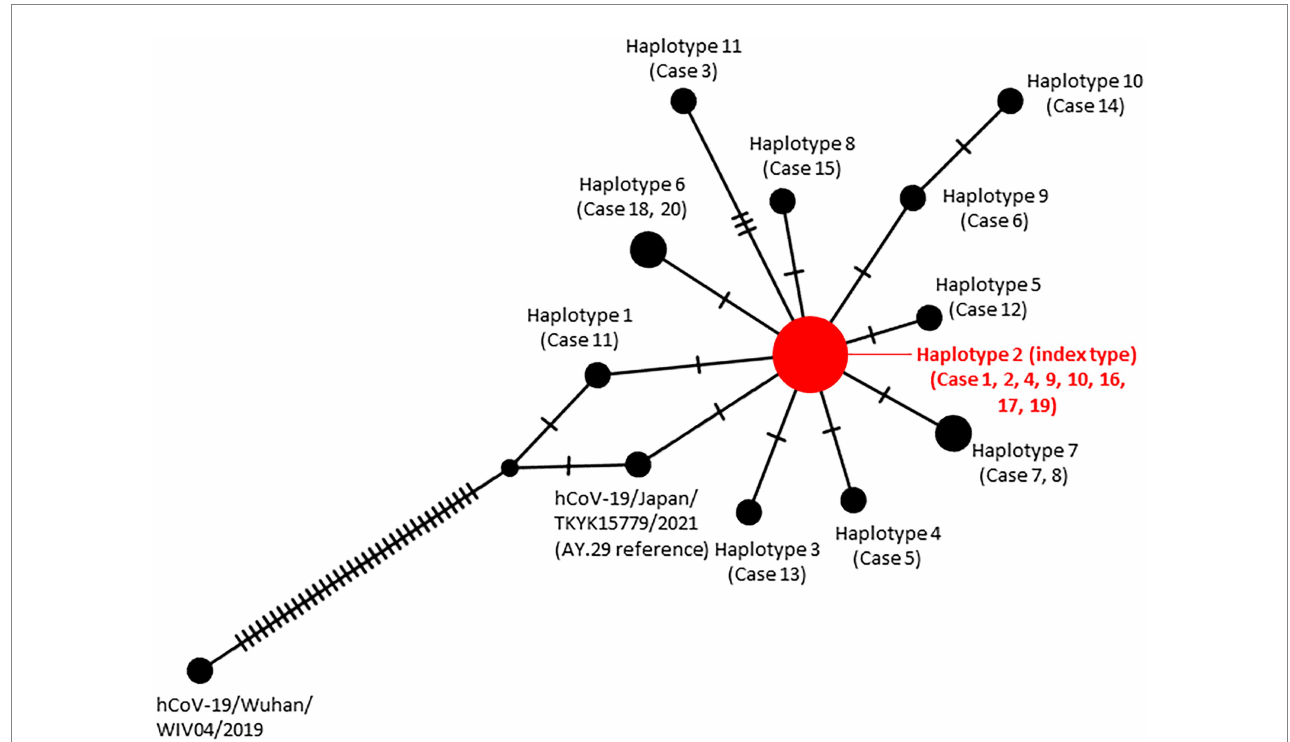
FIGURE 4 Haplotype network analysis of the SARS-CoV-2 genomes identified in the nosocomial cluster. The size of each node is proportional to the number of samples that belong to that